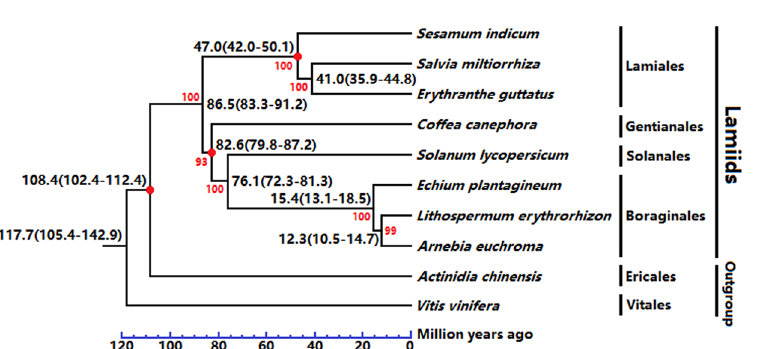
Figure 6. The qRT-PCR verification of the G10H and 12OPR unigenes’ expression profiles between GL and RR lines in Lithospermum erythrorhizon ( Le ), Arnebia euchroma ( Ae ) and Echium plantagineum ( Ep ). ( a ) G10H - LeCL2572 . Contig1 , ( b ) G10H - AeCL6292 . Contig2 , ( c ) G10H - EpCL2694 . Contig1 , ( d ) 12OPR - LeCL2081 . Contig2 , ( e ) 12OPR - AeCL94 . Contig3 , ( f ) 12OPR - EpCL1162 . Contig2 ; Seq. data from RNA-seq, qPCR. data from qRT- PCR; The error bars in the qPCR results represent standard deviation of three biological replicates.